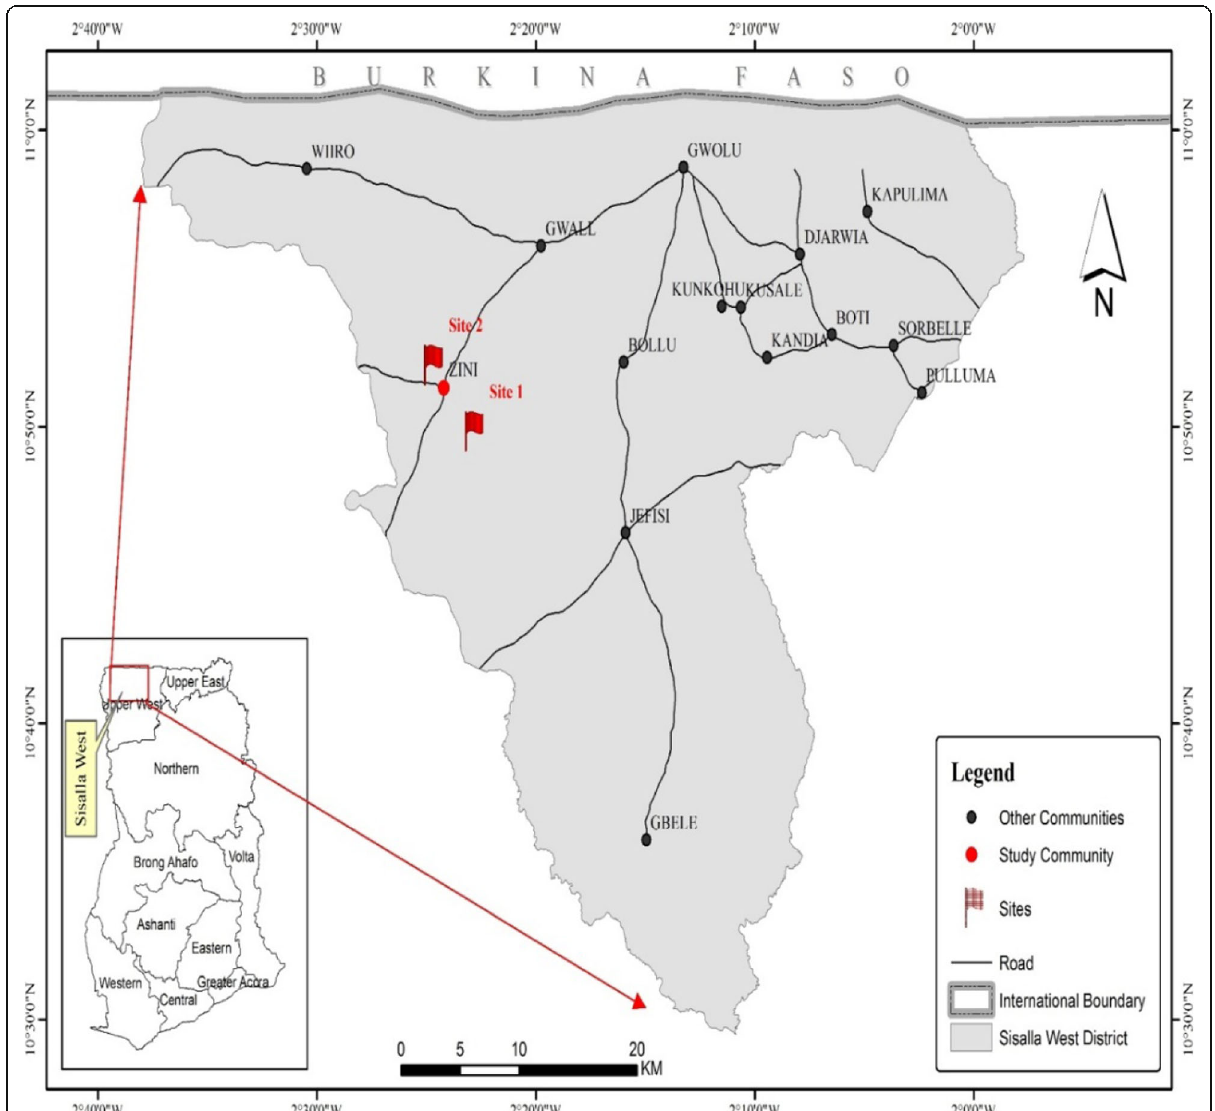
Fig. 1 Map of Sissala West district showing the location of the experimental sites (source: adapted from GSS,